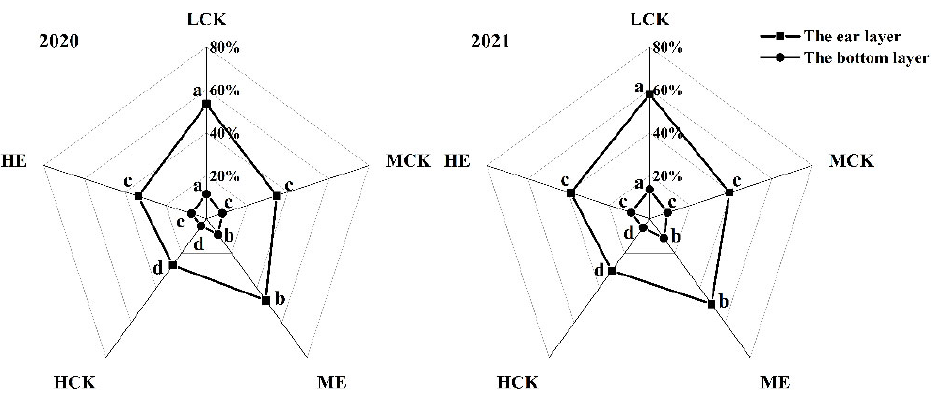
Figure 2. Effects of spraying ethephon on canopy light transmission of summer maize. LCK, MCK, ME, HCK and HE were the treatments of low density control, medium density control, medium density sprayed with ethephon, high density control and high density sprayed with ethephon, respectively. Different lowercase letters in the figure indicated significant difference at 5% level.